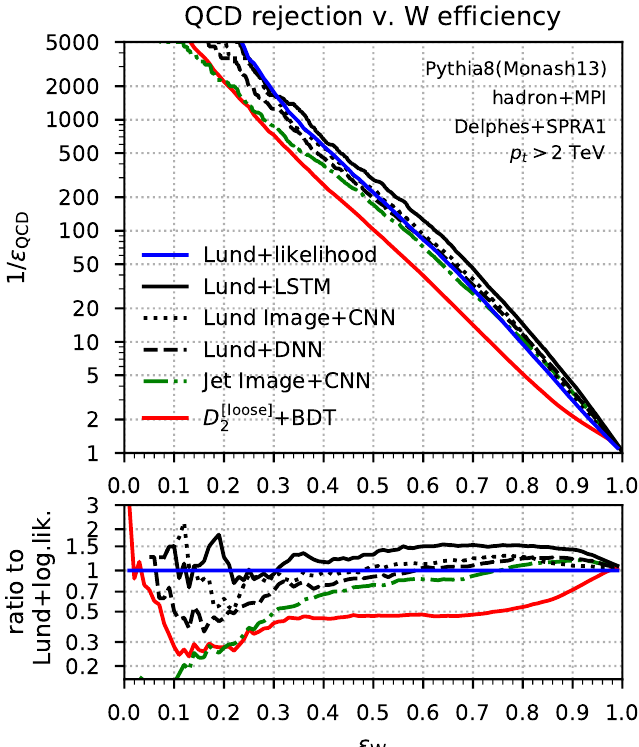
Figure 10. Background rejection (1 =(cid:15) QCD ) versus signal e(cid:14)ciency ( (cid:15) W ), per jet, for di(cid:11)erent W -tagging methods. The lower panel shows the ratio to the Lund+likelihood